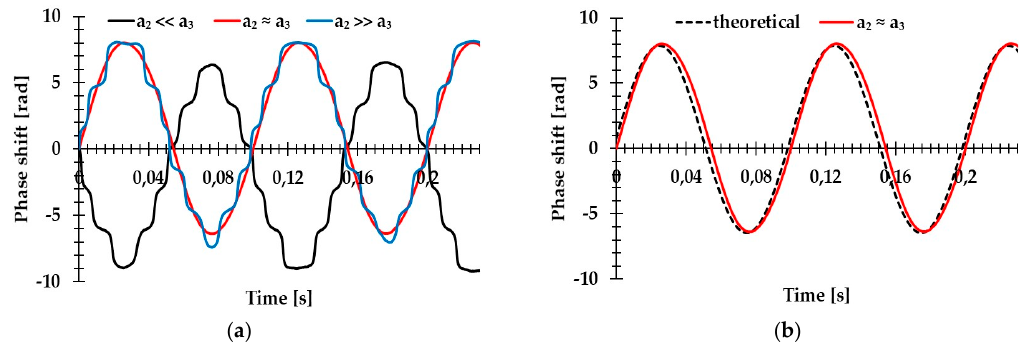
Figure 6 . System calibration. ( a ) Dynamic phase shift measurements at three different values of the distance between two beams d. ( b ) Comparison of the theoretical model (dotted line) and measured phase shift when coefficients a 2 and a 3 are equal. Adapted from [16].